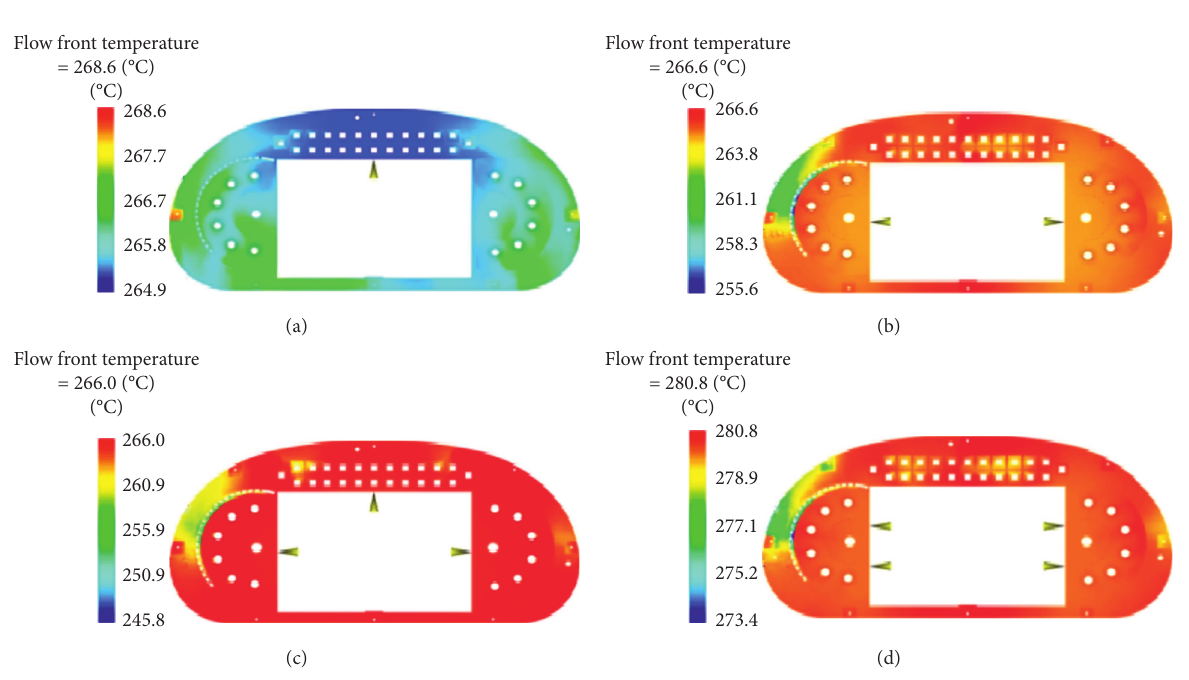
Figure 5: Flow front temperature of four gate configurations.